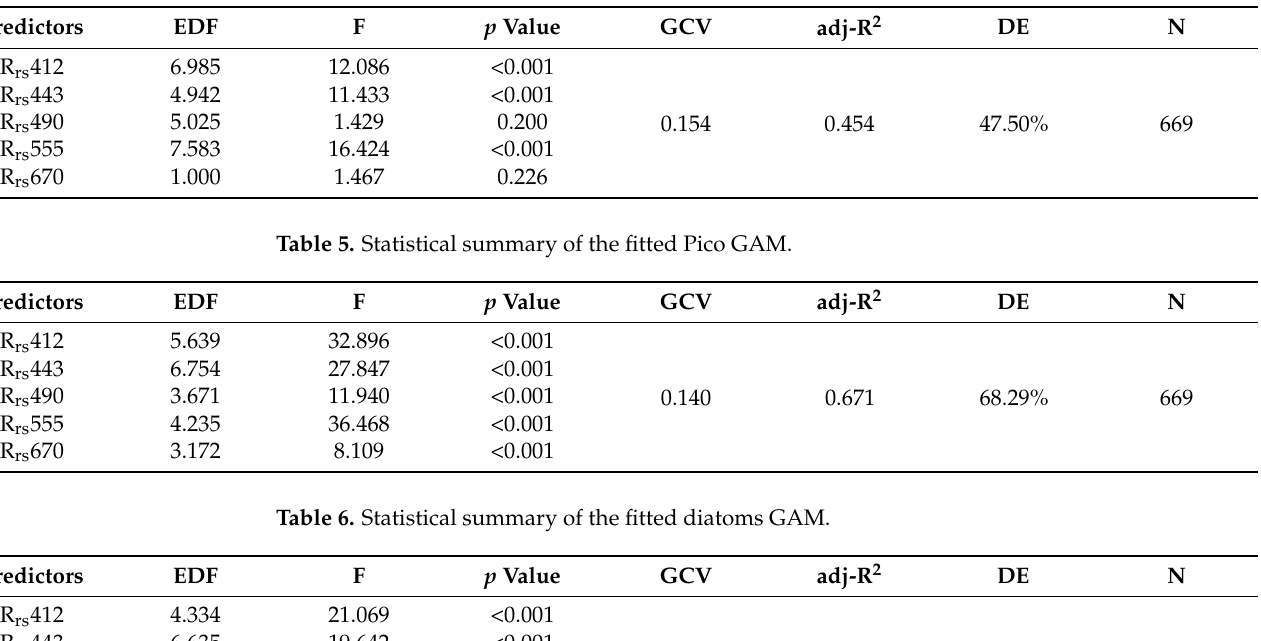
Table 4. Statistical summary of the fitted Nano GAM.